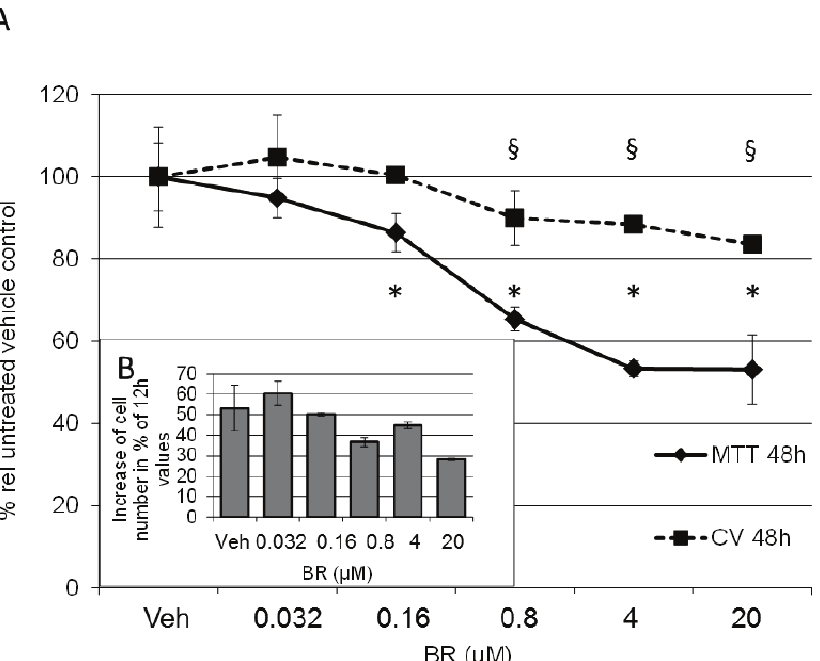
Figure 7. BR results in decreased proliferation and metabolic activity of BRL 3A cells. ( A ) Cells were treated with vehicle (Veh) or BR in the concentrations indicated, and incubated for 48 h. Cell number (squares and dotted line) was determined using crystal violet assay, and expressed in % relative to the vehicle control (CV 48 h). Data are given as means (±SD) obtained from two experiments with n = 2 replicates. Metabolic activity of treated cells was determined by MTT assay (diamonds and full line). Data are given as means (±SD) obtained from one experiment with n = 4 replicates (MTT 48 h). Significant differences to the control are indicated as (*, §); ( B ) Determination of cell numbers within one experiment at consecutive time points (12 h and 48 h) showed a decreased proliferation rate in the presence of